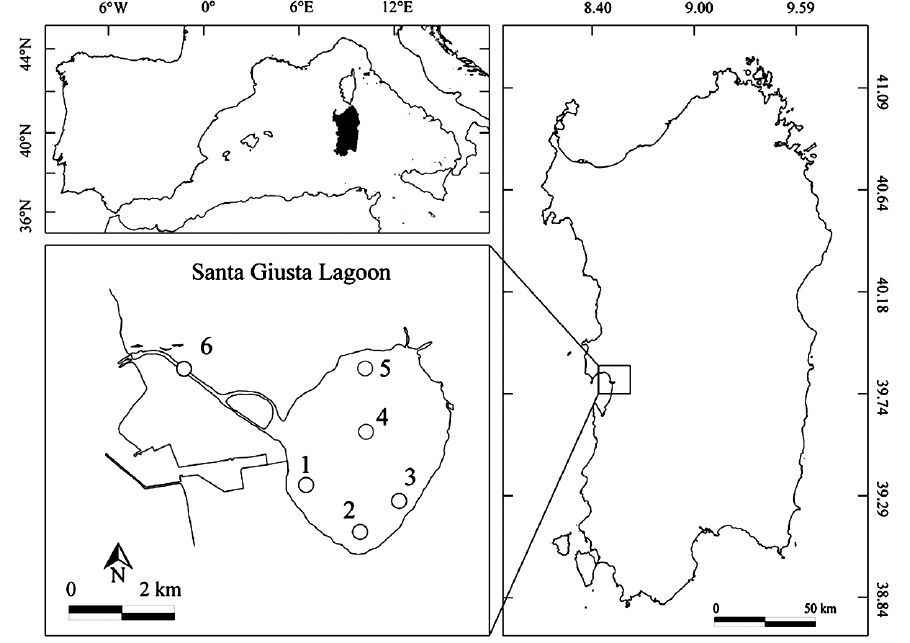
Fig. 1. – Santa Giusta Lagoon and sampling